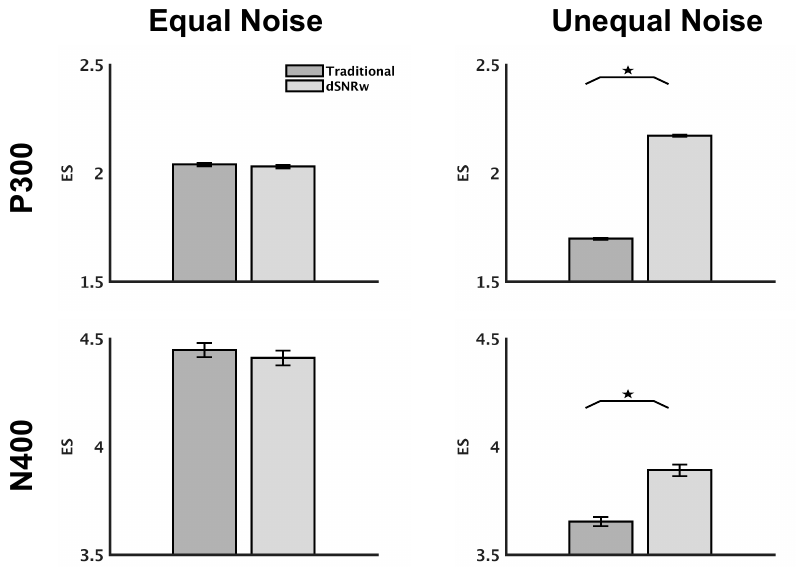
Figure 3. Effect size measurements for simulated P300 and N400 ERPs with varying noise levels for channels being combined. Results are presented as mean ± SEM. The dSNRw signal combinatorial approach outperformed the traditional channel pooling technique in the presence of unequal noise levels for both simulated P300 and N400 ERPs. No significant differences among the techniques were observed for the situation of equal noise levels in the channels being pooled. * p < 0.001 across signal pooling techniques.